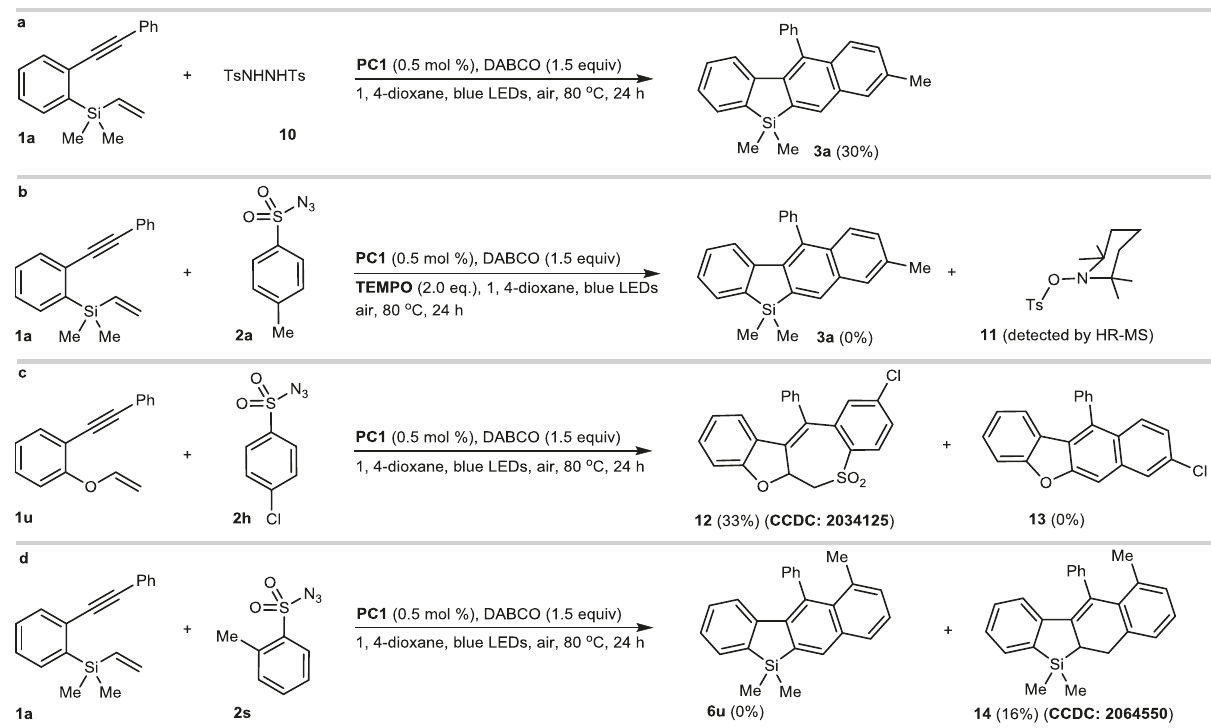
Fig. 7 Preliminary mechanism studies. a Photocatalyzed cycloaromatization of vinylsilane 1a with sulfonylhydrazine 10 . b Radical intermediate trapping reaction by TEMPO. c Photocatalyzed coupling-cyclization of vinylether 1u with arylsulfonylazide 2h . d Photocatalyzed coupling-cyclization of vinylsilane 1a with ortho -methylphenylsulfonyl azide 2s